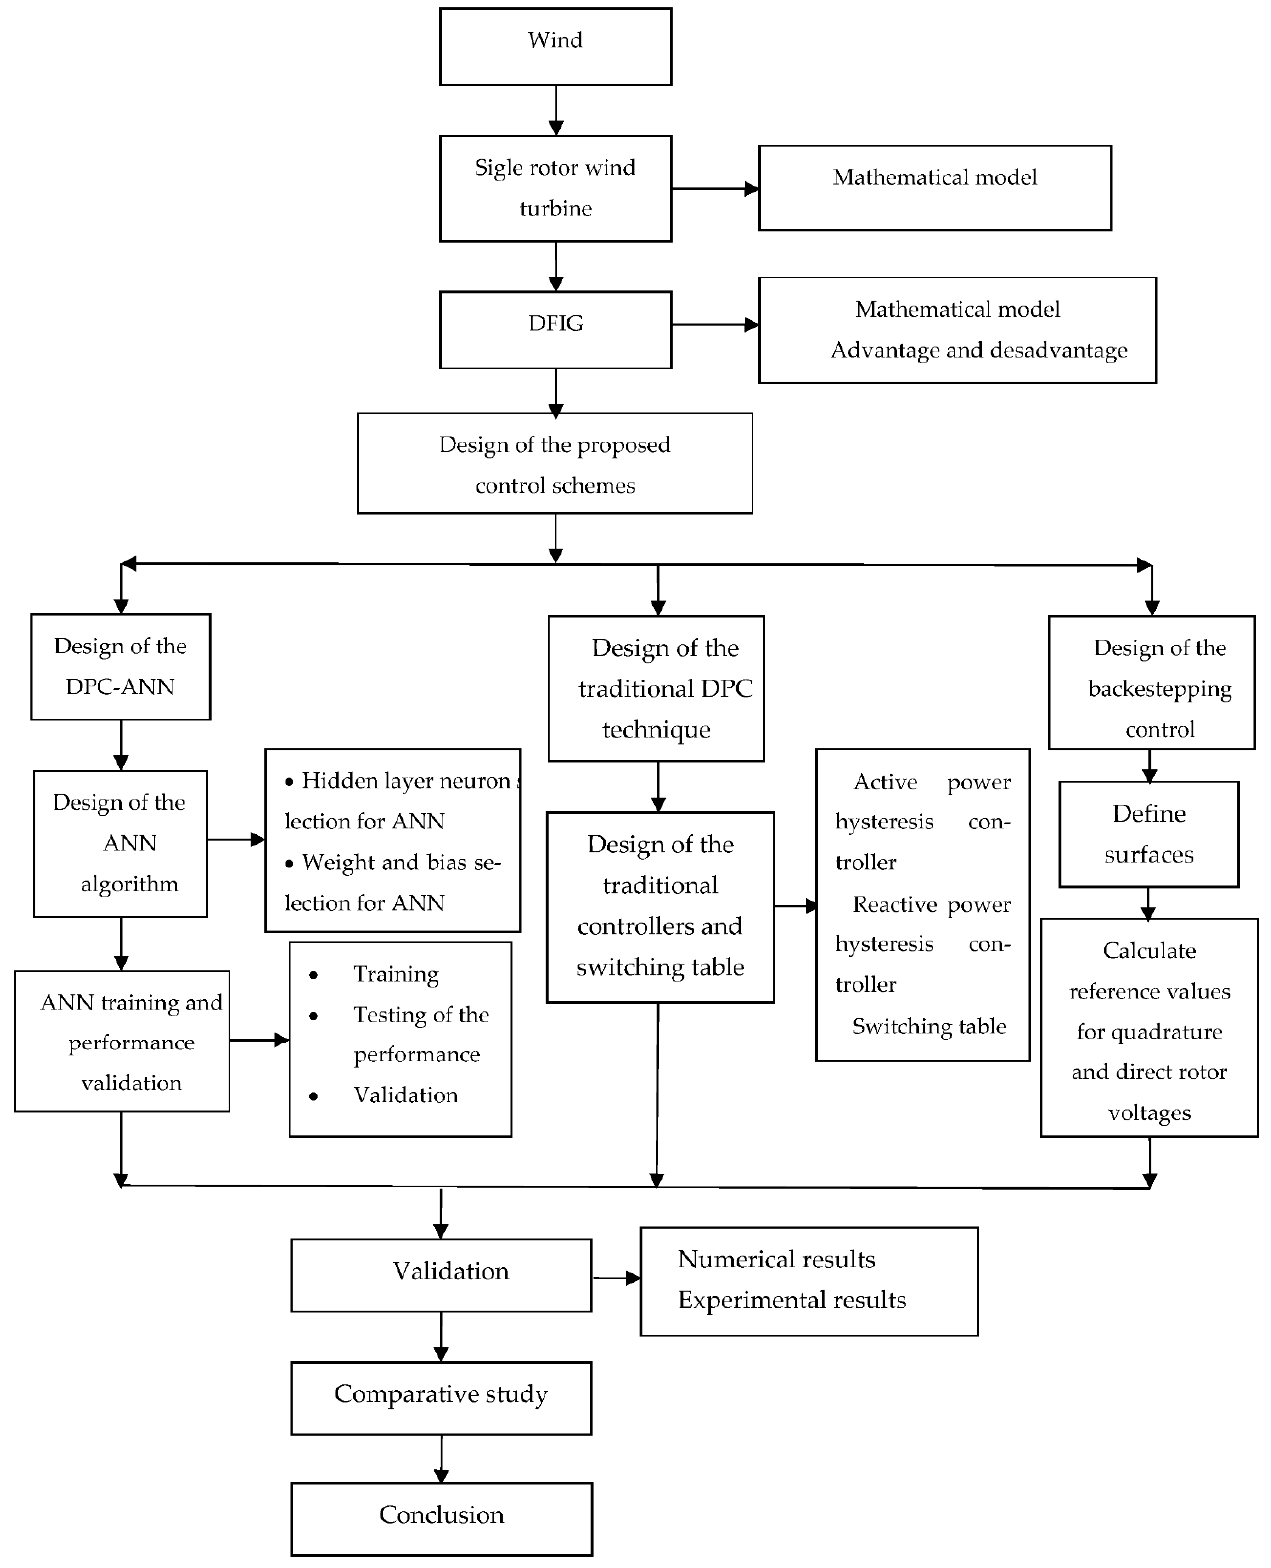
Figure 1. Diagram for proposed